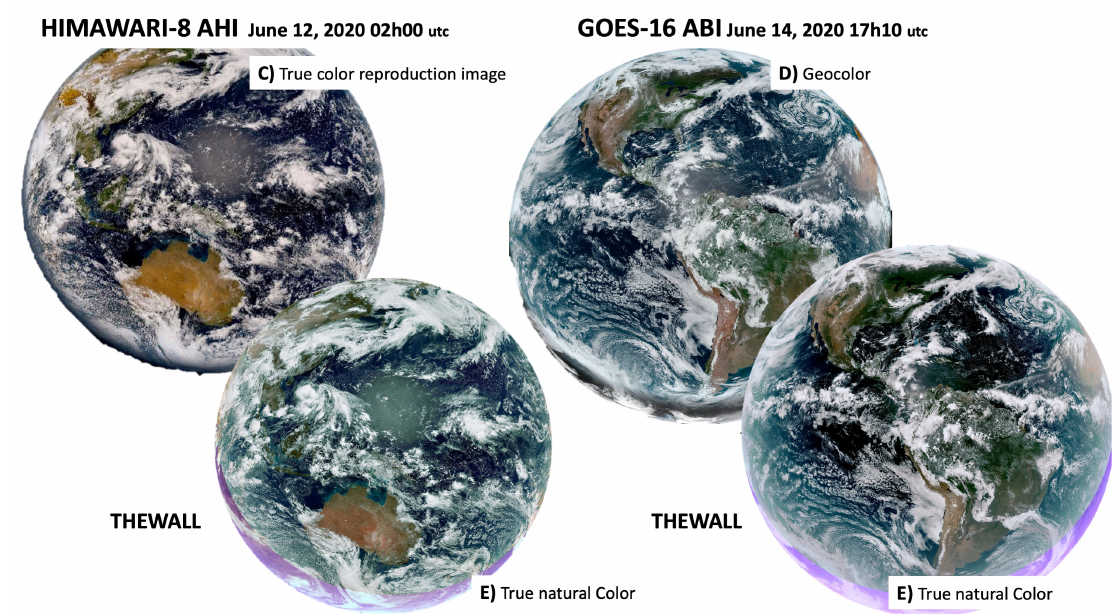
Figure 1. Illustrations of existing color renderings labeled as ( A ) natural color RGB , ( B ) natural color RGB (Enhance) , and ( C ) True color reproduction image created for Himawari-8 AHI. ( D ) GeoColor created for GOES-16 ABI; ( E ) true natural color RGB composites from this work for “The Wall” application (Himawari-8 AHI, MSG2 SEVIRI and GOES-16